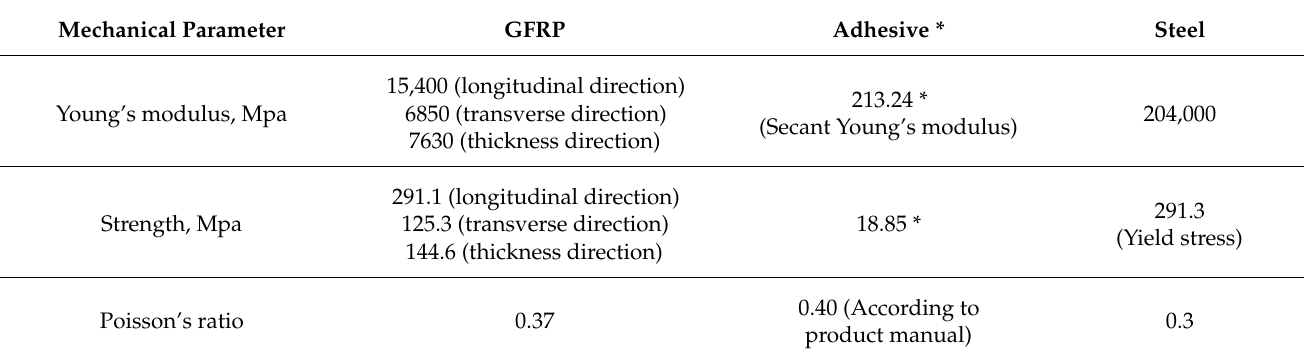
Table 1. Mechanical properties of the GFRP, adhesive, and steel. Mechanical